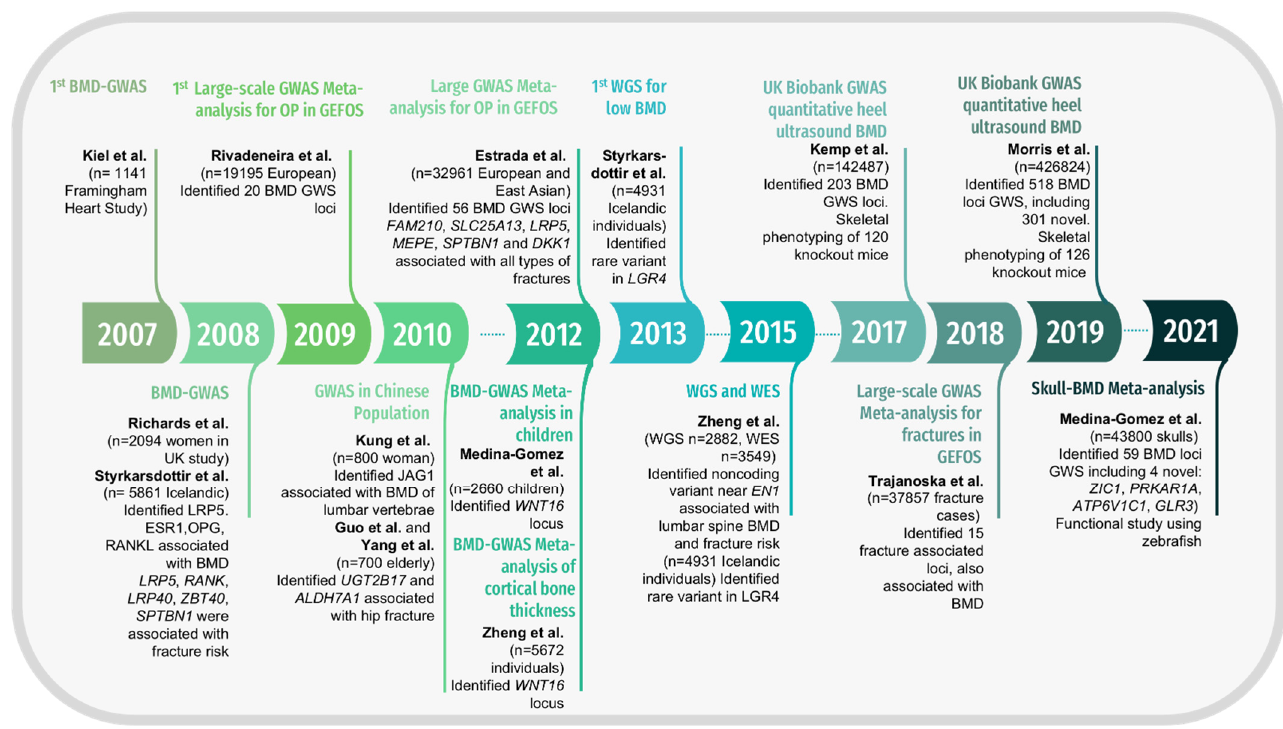
Figure 1. Timeline highlighting important milestones of GWAS for BMD. GWS (Genome-wide sig- nificant).